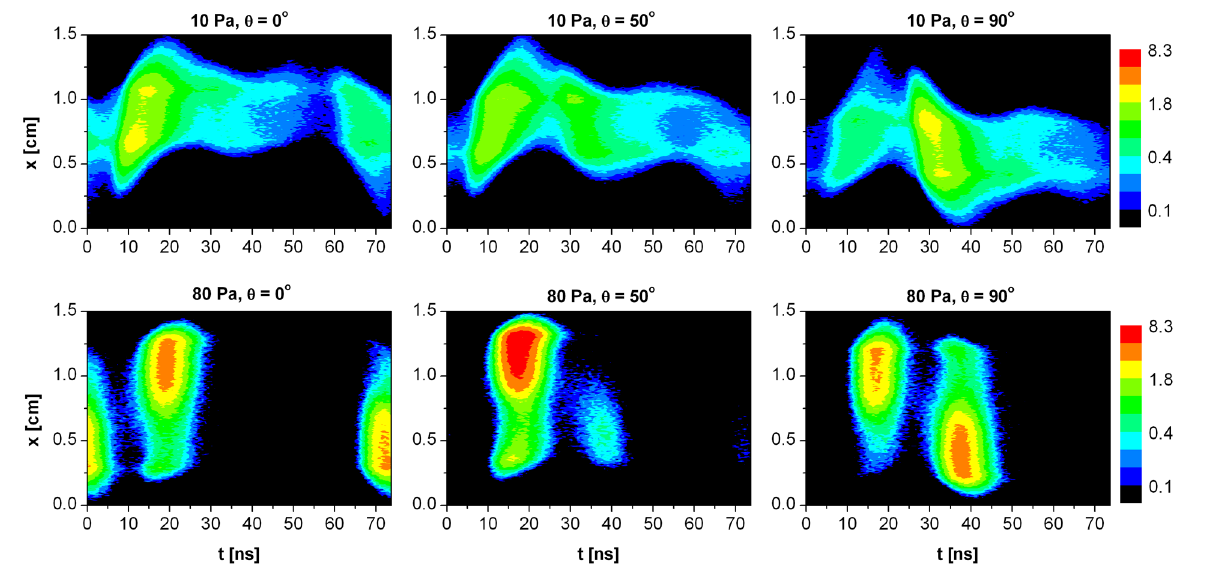
Figure 8 : Spatio-temporal distribution of the ionization rate in electrically asymmetric dual-frequency discharges operated at 13.56 MHz + 27.12 MHz for different values of the phase shift between the driving harmonics, θ, at 10 Pa, Φ Φ =Φ = 50 V (second row). The color scales, given in 10 21 m -3 s -1 , are logarithmic, and apply to all plots in the same LF HF